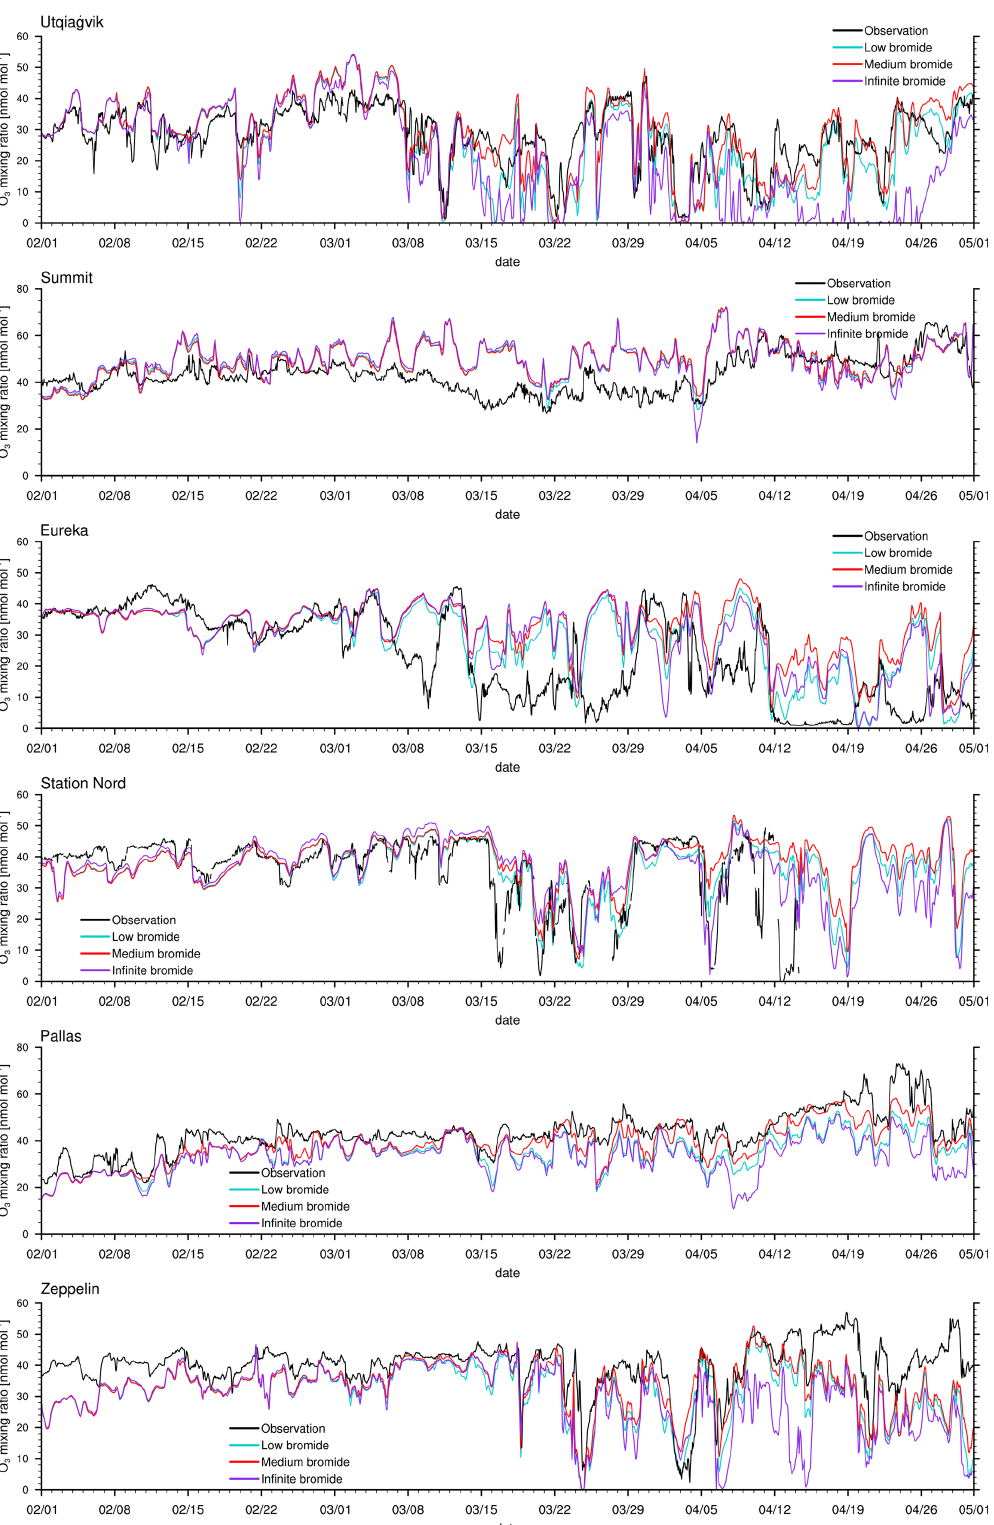
Figure 3. Modeled and observed ozone mixing ratios at Utqia˙gvik, Summit, Eureka, Station Nord, Pallas, and Zeppelin Mountain from top to